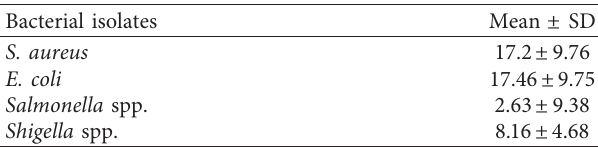
Table 5: Zone diameters of multidrug that were found resistant against bacterial organisms.